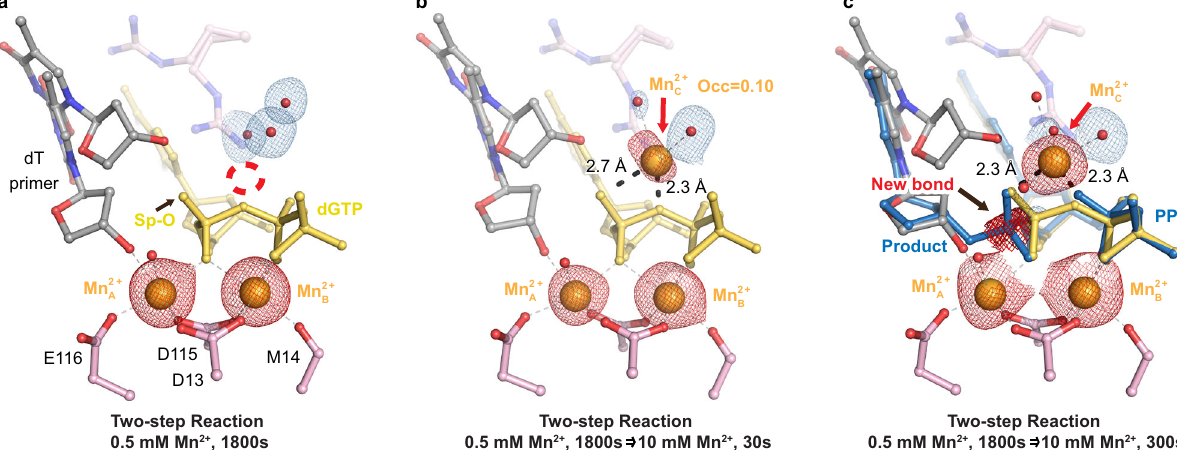
Fig. 4 The Me 2 + C is essential for misincorporation. Structures of Pol η in crystallo after 0.5 mM Mn 2 + soaking ( a ) and subsequent 10 mM Mn 2 + soaking for 30 s ( b ) and 300 s ( c ). The 2F o -F c map for all the water molecules coordinating the Me 2 + C was contoured at 0.7 σ . The F o -F c omit map for all Mn 2 + ions and new bond density (red) was contoured at 3 σ